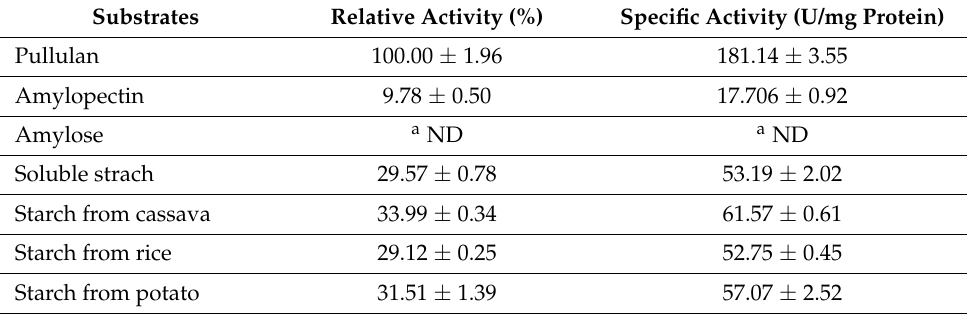
Table 1. Substrate specificity of HL12Pul against various substrates.